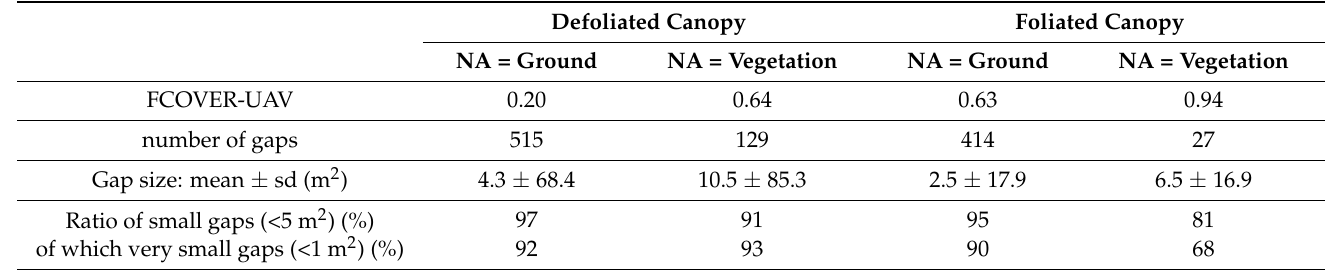
Figure 3. Results of ground classifications at different acquisition dates compared to DSMs. Ground masks derived from point clouds are shown in light blue and dark blue outlines for the ( a ) spring and ( b ) summer acquisition dates. Table 2. Gap numbers, sizes and derived FCOVER-UAV depending on the assumptions in ground